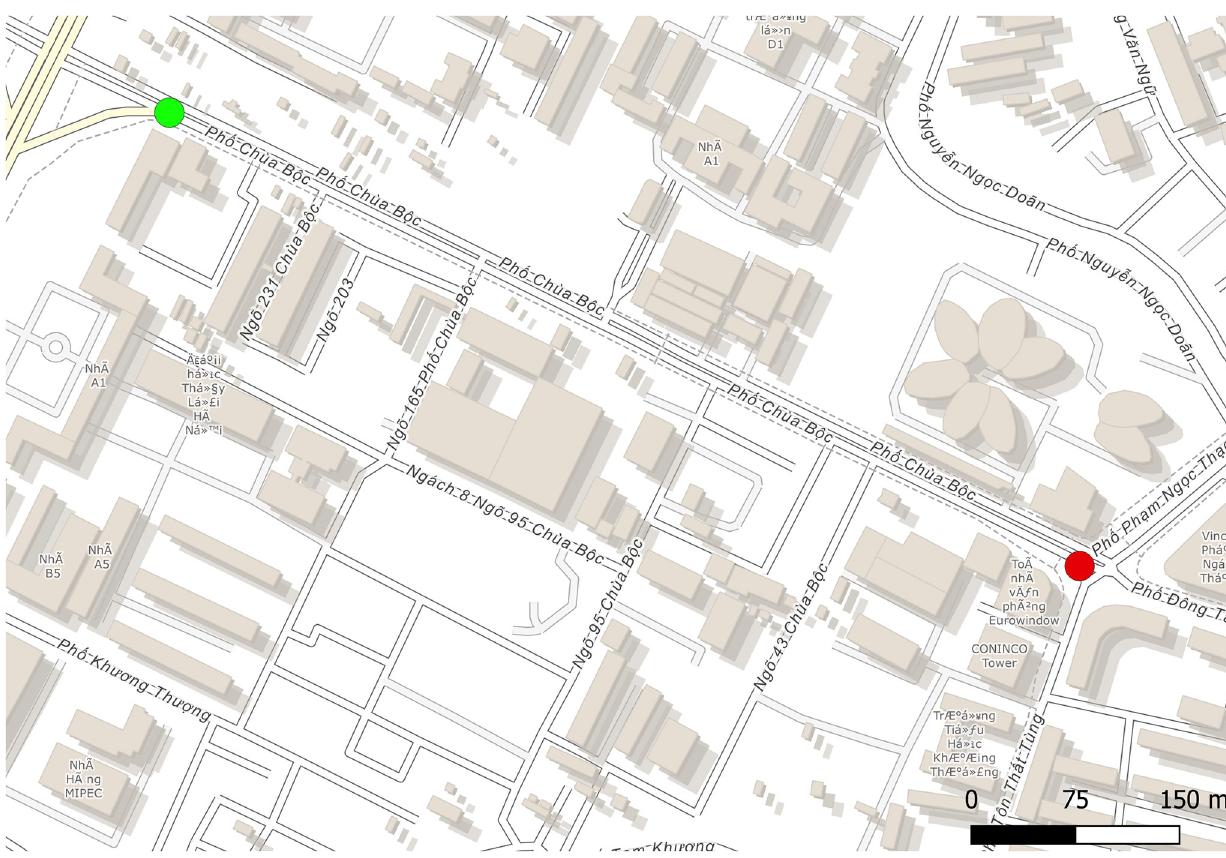
Fig 5. Chua Boc street site (based on OpenStreetMap data): The green circle represents the input point (WGS84 coordinates: (105.8252 21.0089)), and the red circle the output point (WGS84 coordinates: (105.831 21.0062)).